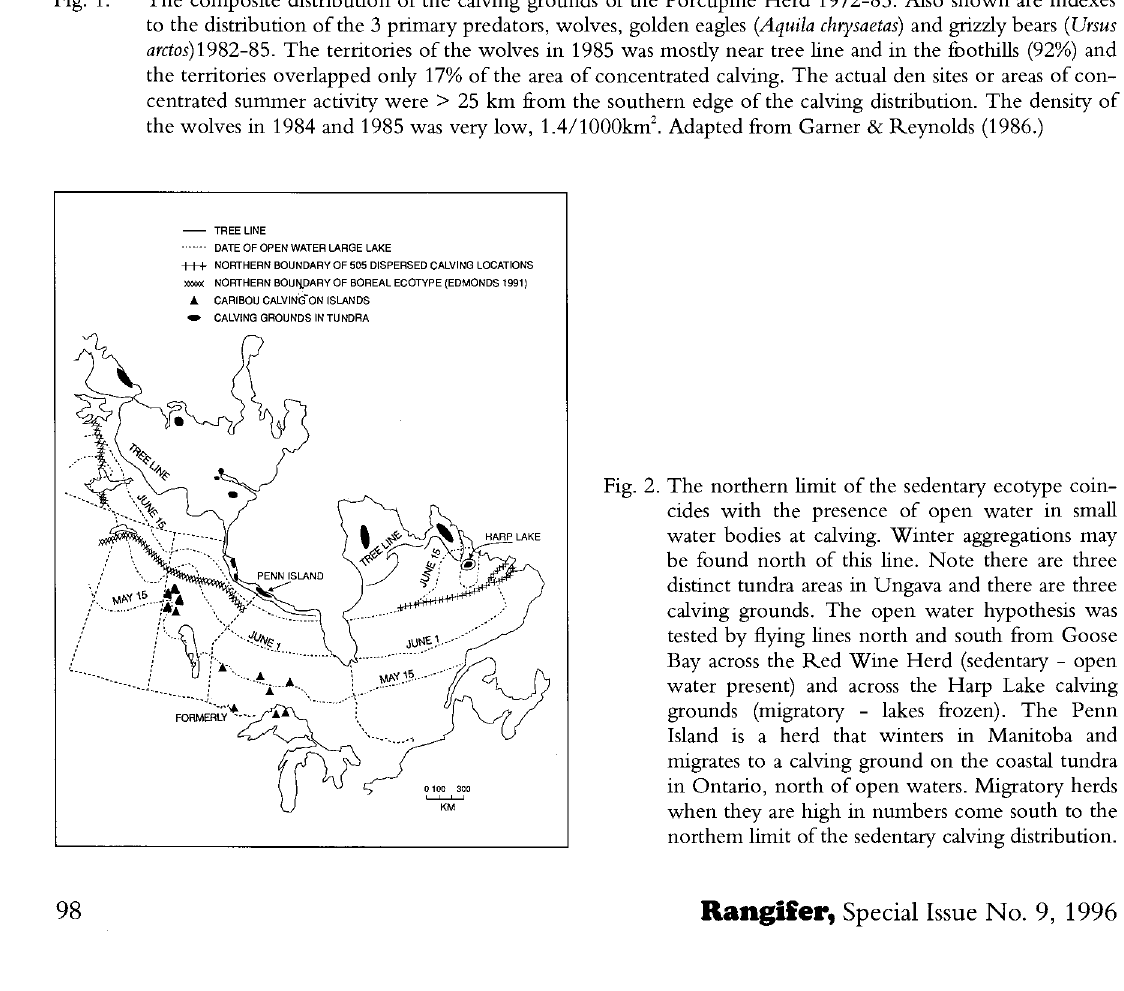
Fig. 2. The northern limit of the sedentary ecotype coin cides with the presence of open water in small water bodies at calving. Winter aggregations may be found north of this line. Note there are three distinct tundra areas in Ungava and there are three calving grounds. The open water hypothesis was tested by flying lines north and south from Goose Bay across the Red Wine Herd (sedentary - open water present) and across the Harp Lake calving grounds (migratory - lakes frozen). The Penn Island is a herd that winters in Manitoba and migrates to a calving ground on the coastal tundra in Ontario, north of open waters. Migratory herds when they are high in numbers come south to the northern limit of the sedentary calving